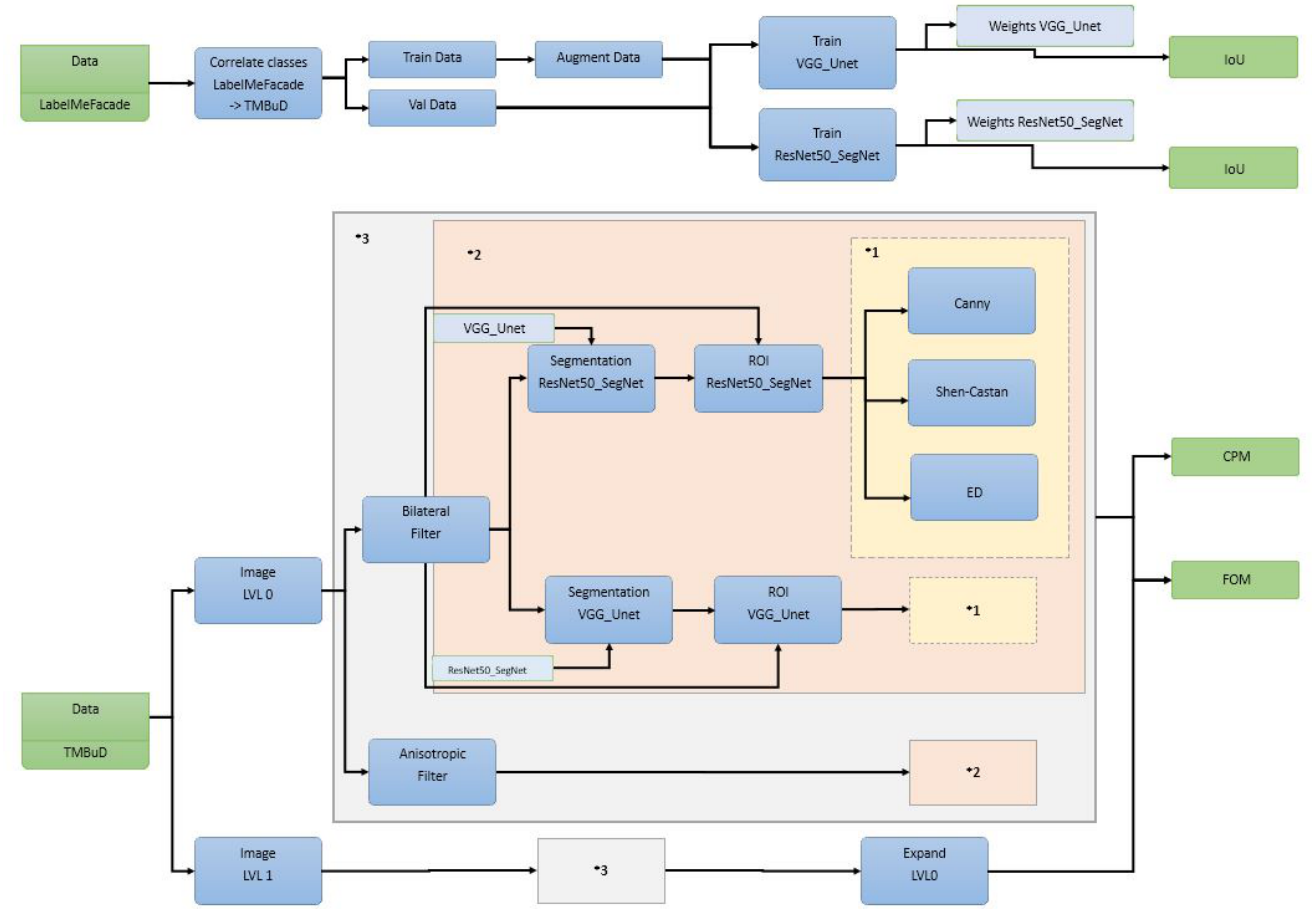
Figure 10. EECVF example logical